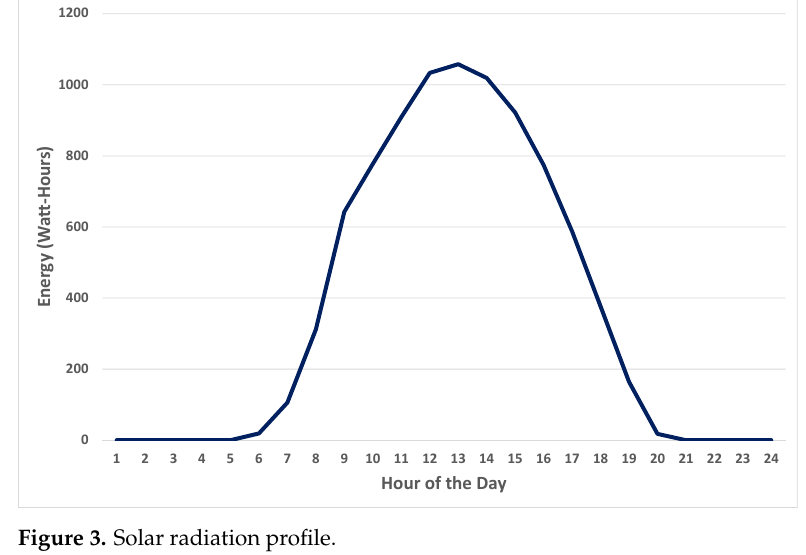
Figure 3. Solar radiation profile.